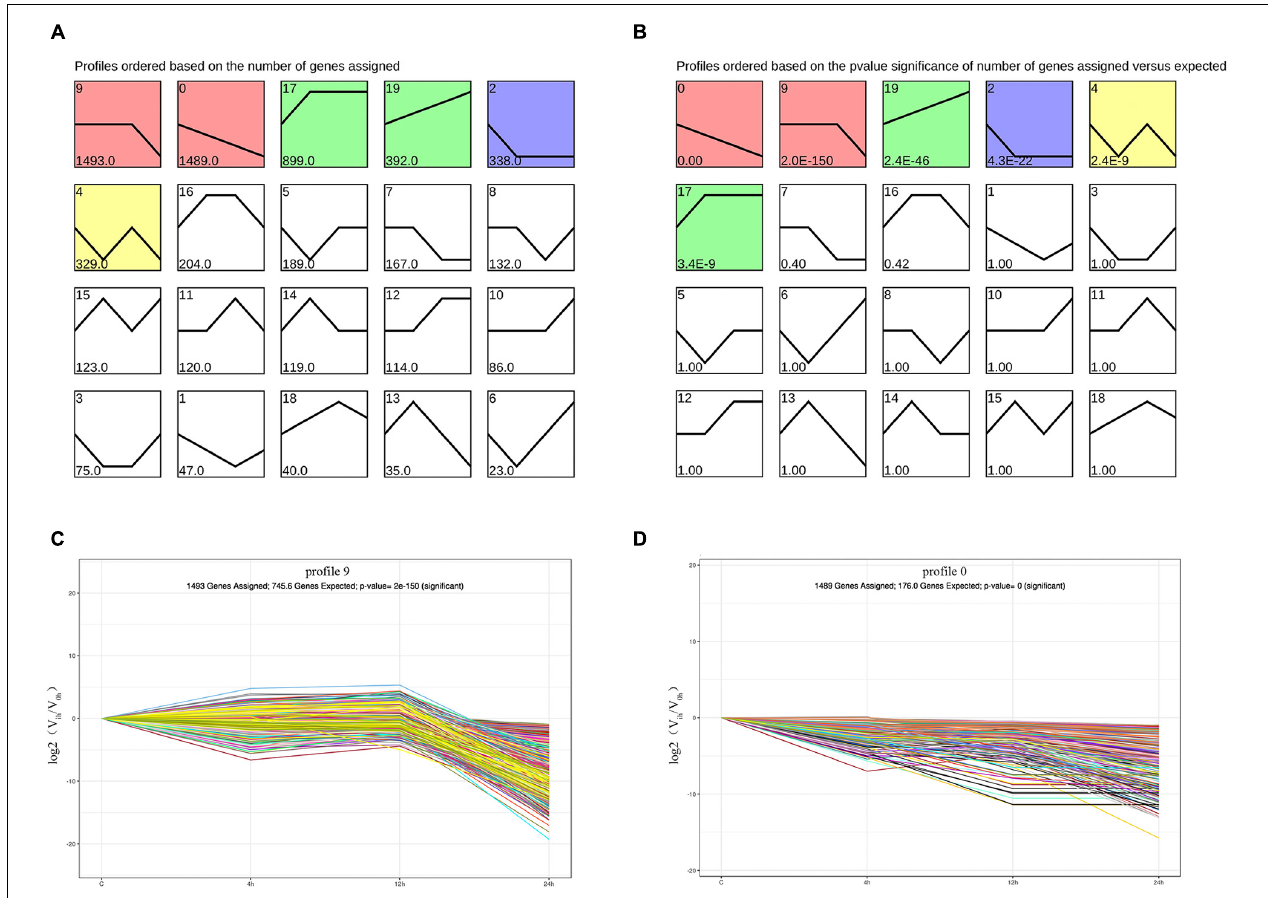
FIGURE 4 | Trend analysis was used to analysis the trend changes of DEGs. (A) Trend analysis results sorted by the number of enriched DEGs. (B) Trend analysis results sorted by p -value. (C) The expression trend of DEGs in profile 9. The x -axis lists the time point after hatching; the y -axis indicates log2(fold change). (D) The expression trend of DEGs in profile